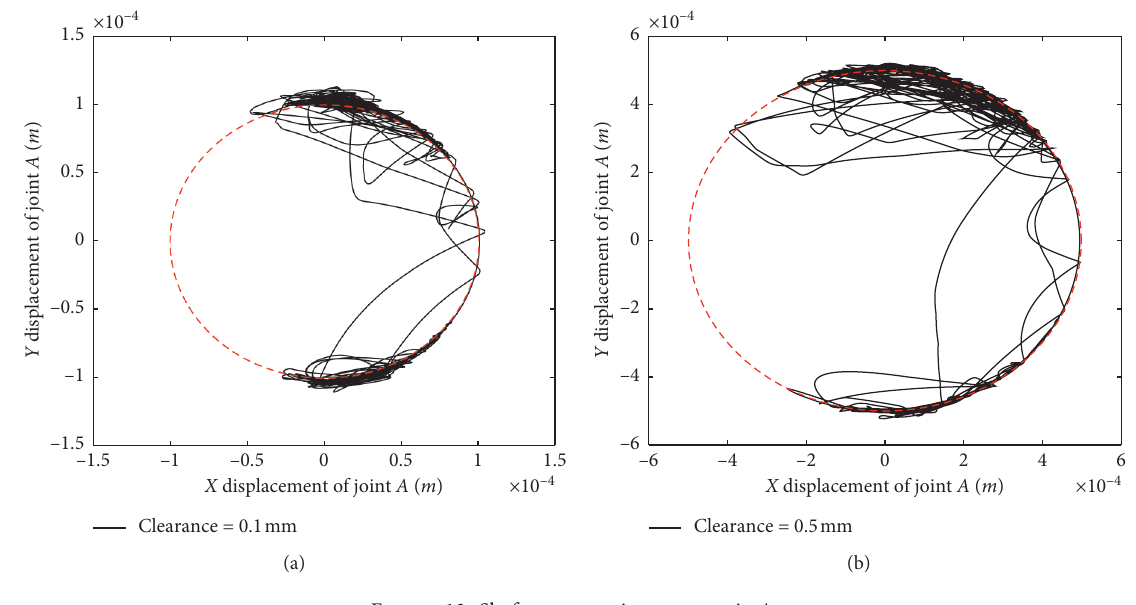
Figure 13: Shaft center trajectory at pair A